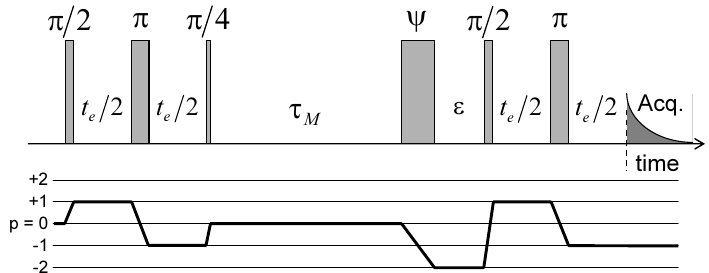
Figure 11. Pulse sequence and coherence pathway used to measure the attenuation of the two-time 2 H NMR stimulated echo I ( t e , τ M ) as a function of the evolution period t e and the mixing time τ M . The fourth pulse duration, noted ψ , is optimised in order to maximise the transfer from T 20 to T 22 ( s ) coherence and simultaneously minimise the transfer from T 10 to T 22 ( a ) coherence. Reprinted with permission from [23]. Copyright (2014) American Chemical